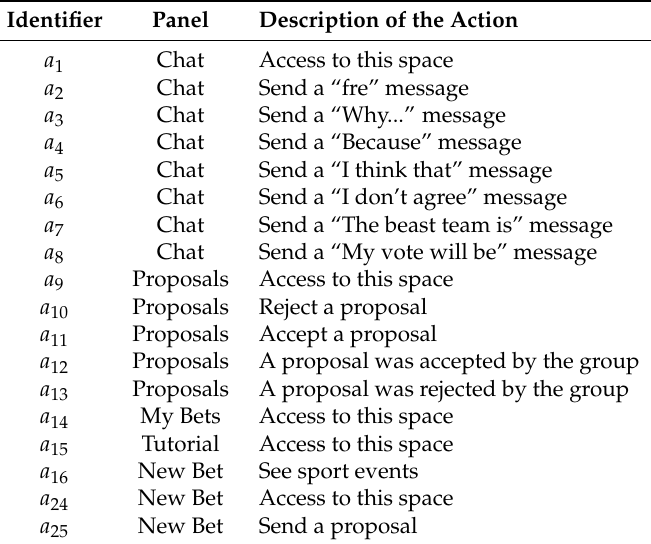
Table A1. Actions of the groupware